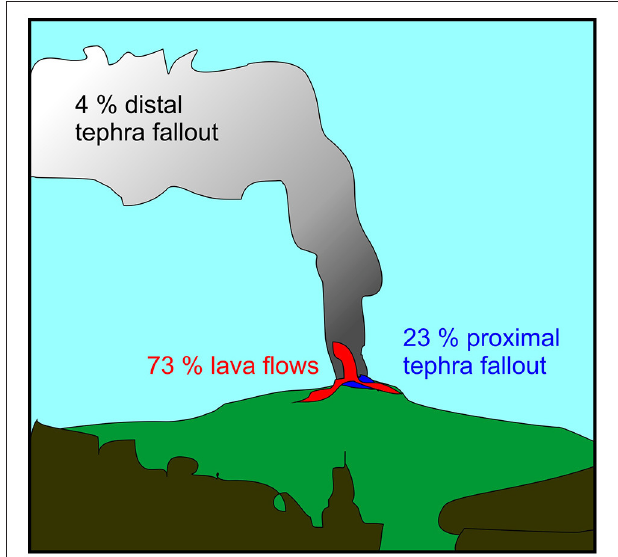
FIGURE 9 | Schematic diagram of proposed magma (DRE %) distribution in terms of lava, distal tephra and proximal tephra deposits erupted during the 25-26 October 2013 lava fountain at